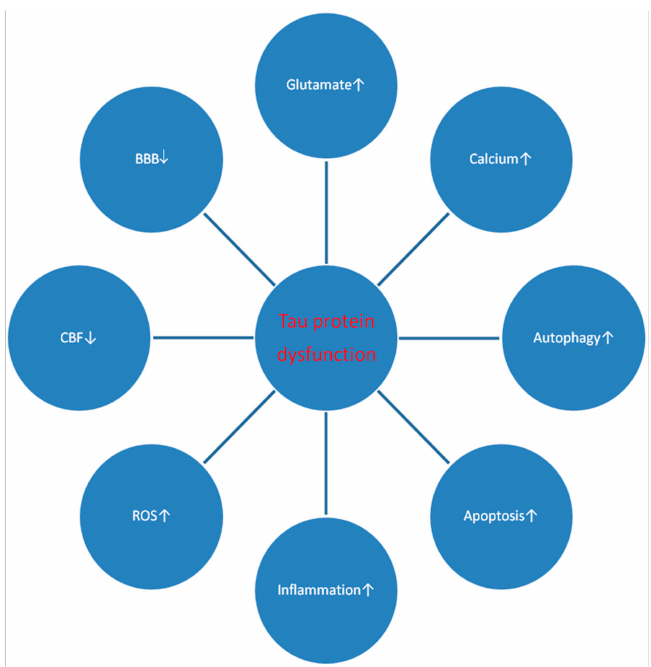
Figure 2. Potential regulatory mechanisms of dysfunctional tau protein in post-ischemic brain neuropathology. ↓ - decrease, ↑ - increase. BBB–blood–brain barrier, CBF–cerebral blood flow, ROS–reactive oxygen